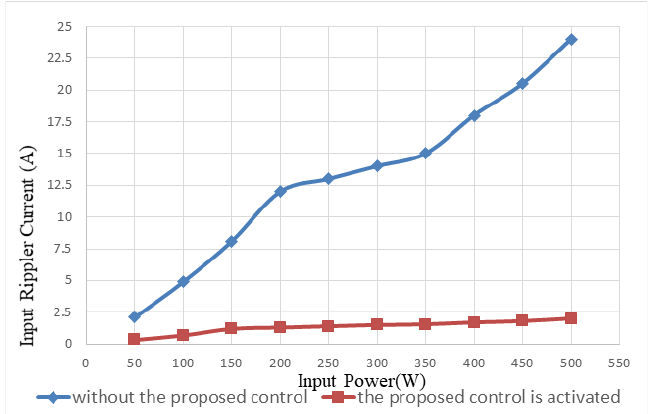
Figure 17. Measured results are compared with proposed method under different loads.